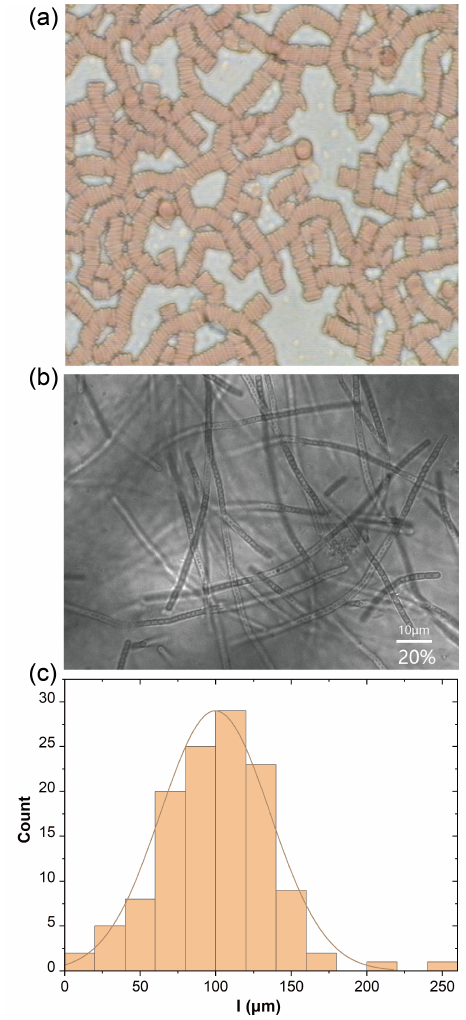
Figure 1. ( a ) A typical self-assembled RBC structure of human blood (the diameter of RBC (8 µ m) as a scale); ( b ) a typical structure of Phormidium suspensions; ( c ) the length distribution of Phormidium